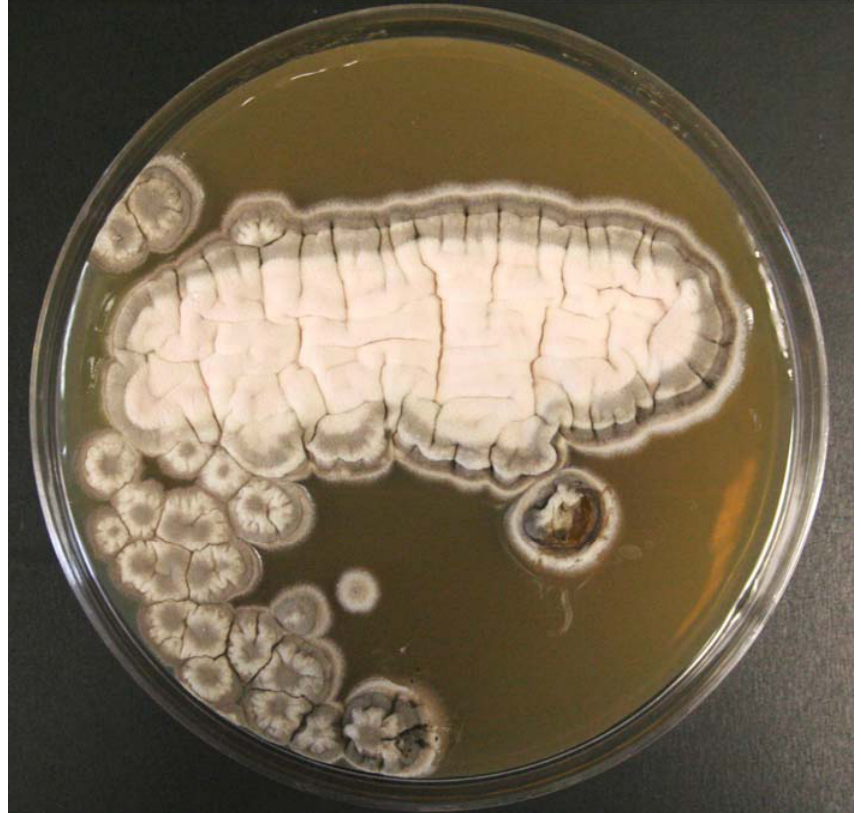
Figure 1. A petri dish culture of the mycopathogenic fungus Humicola fuscoatra , one